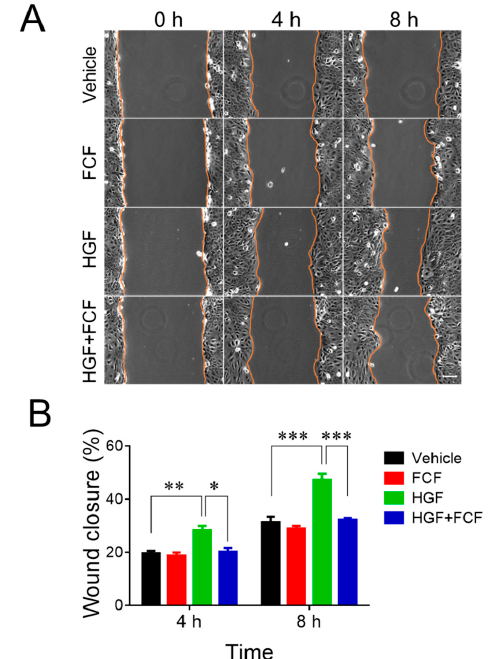
Figure 2. Forchlorfenuron attenuates hepatocyte growth factor-induced migration of prostate epithelial cells. Confluent DU145 cell monolayers were pretreated for 2 h with either FCF (50 µ M), or vehicle (DMSO), and wounded. Spontaneous and HGF (25 ng/mL)-induced wound closure with, or without, FCF was examined at the indicated time points. ( A ) Representative images of wounded DU145 cell monolayers. ( B ) Quantitation of wound closure during 4 and 8 h of cell migration. Data are presented as a mean ± SE ( n = 5); * p < 0.05, ** p < 0.01, *** p < 0.001. Scale bar, 100 µm.